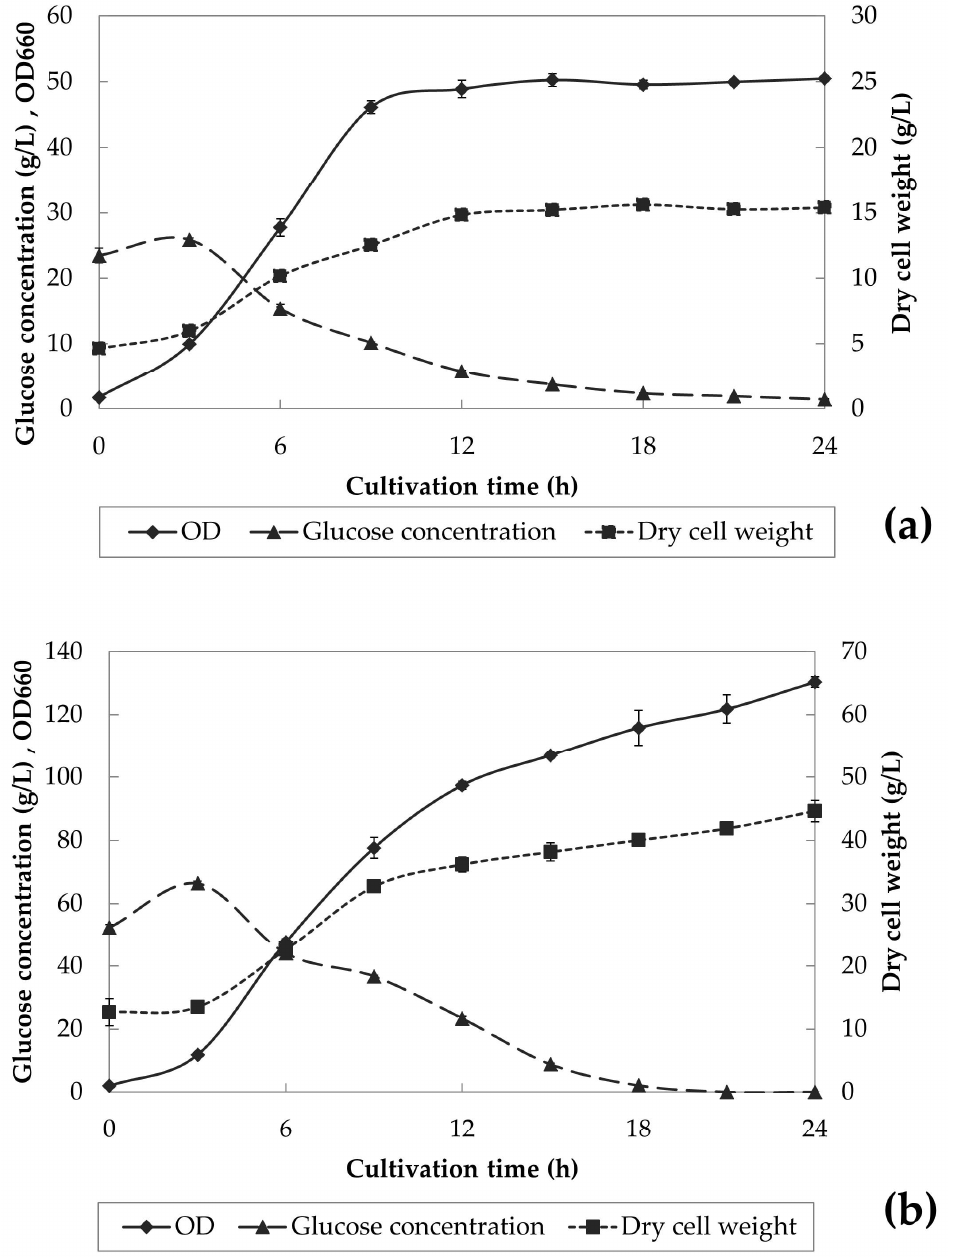
Figure 3. Changes in the optical density (diamonds), glucose (squares), and cell concentration (triangles) of K. marxianus SS106 in aerobic batch simultaneous saccharification and cultivation using ( a ) 50 g / L and ( b ) 100 g / L of liquefied starch as the substrate. 3.6. Intensive Multiple Sequential Batch Simultaneous Saccharification and Cultivation of K. marxianus